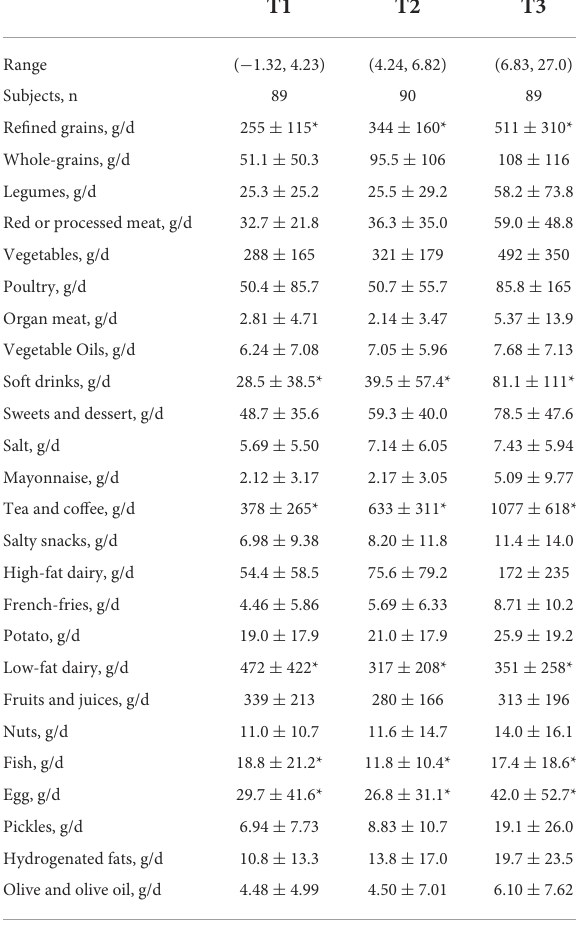
TABLE 2 Dietary intakes of the study participants according to the tertile of